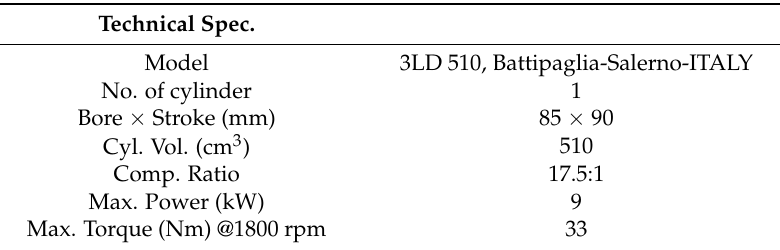
Figure 2. Engine test set-up and test instruments. Table 3. Specifications of diesel